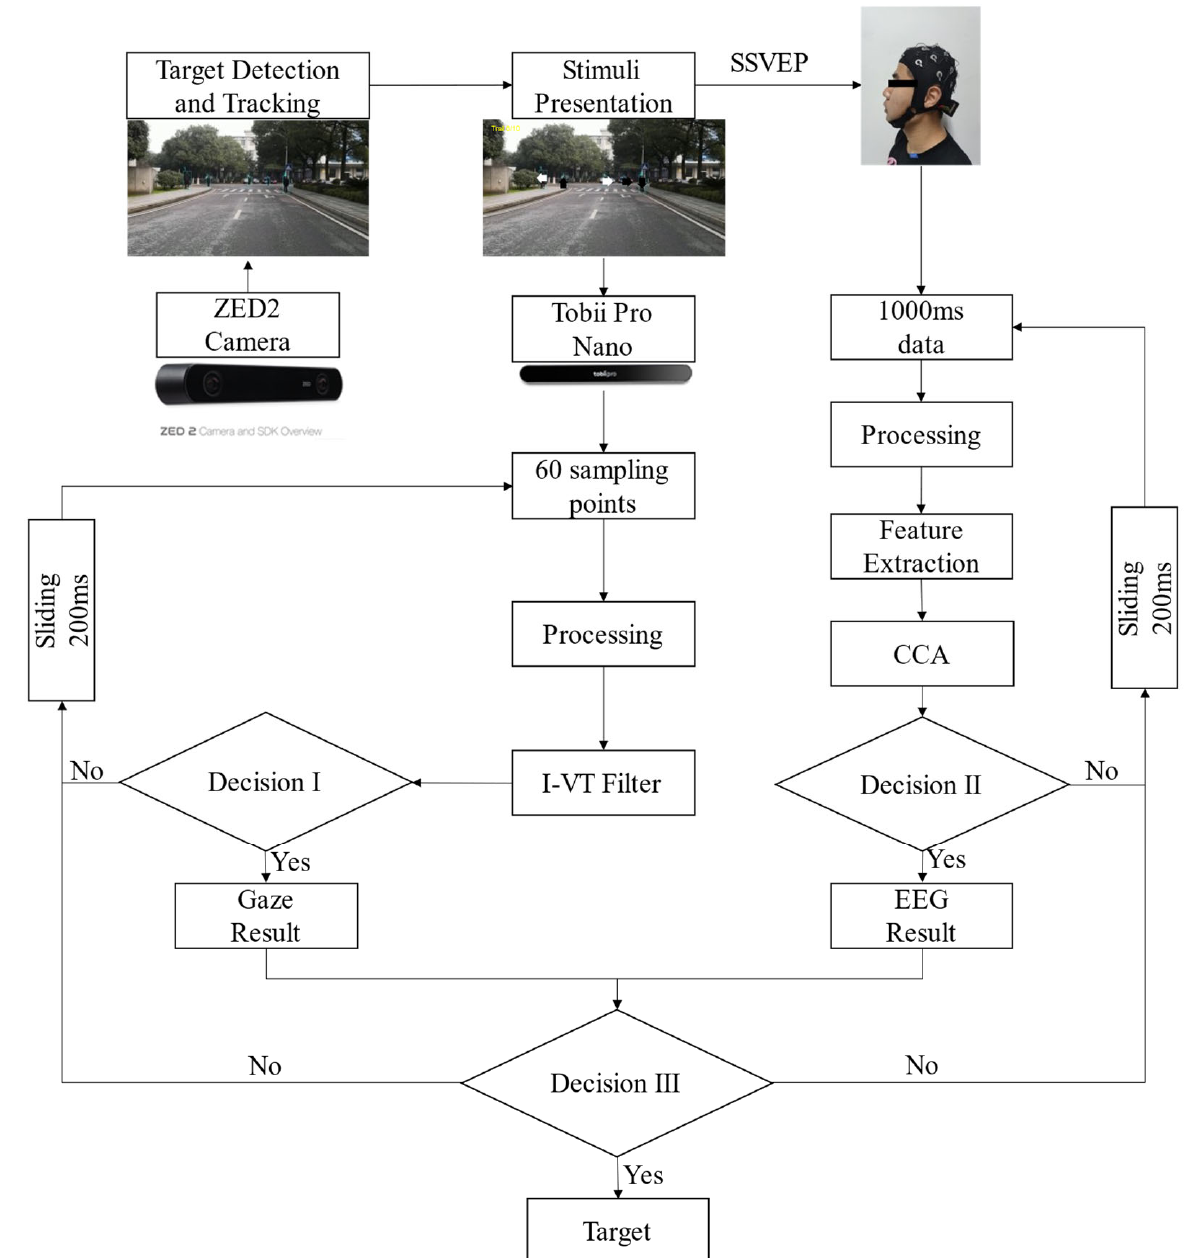
Figure 1. Hybrid asynchronous BCI system for dynamic pedestrian detection.